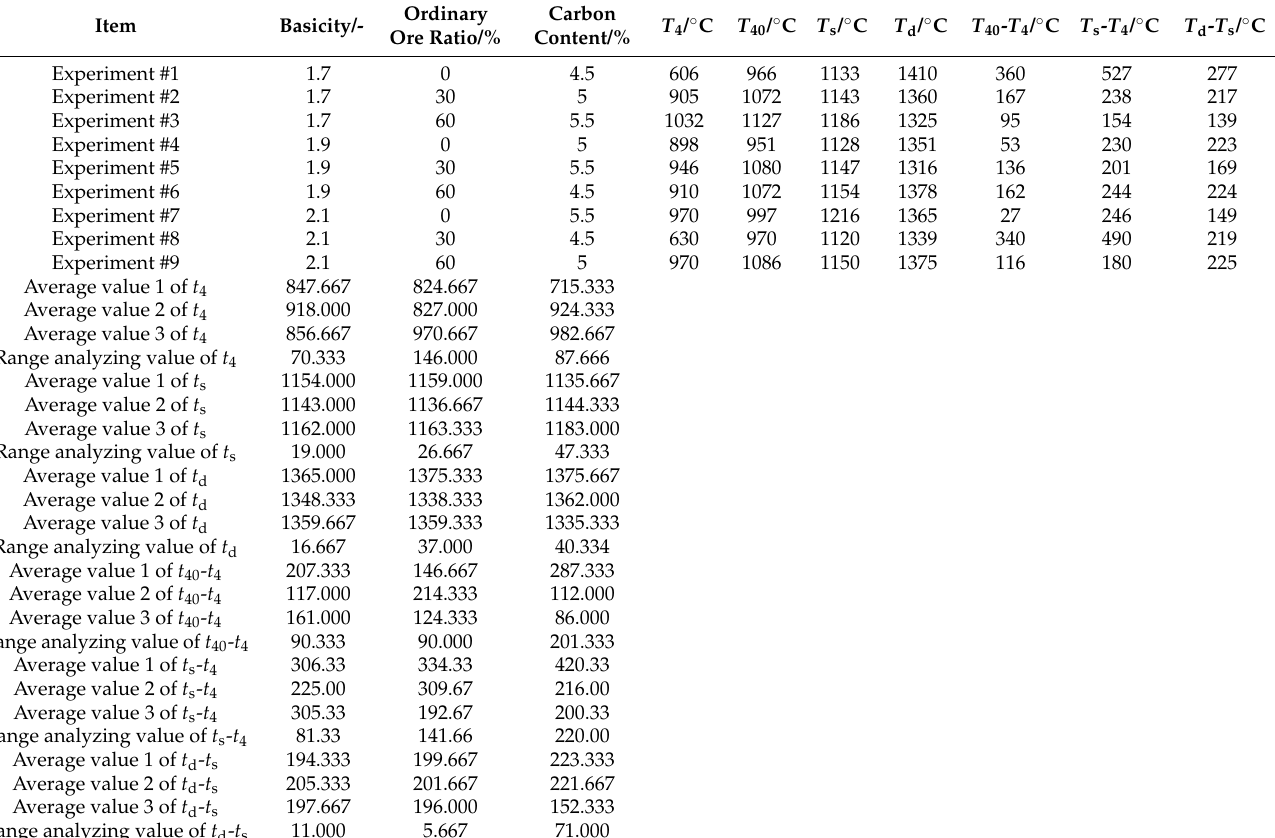
Table 13. Range analysis of softening and melting temperature